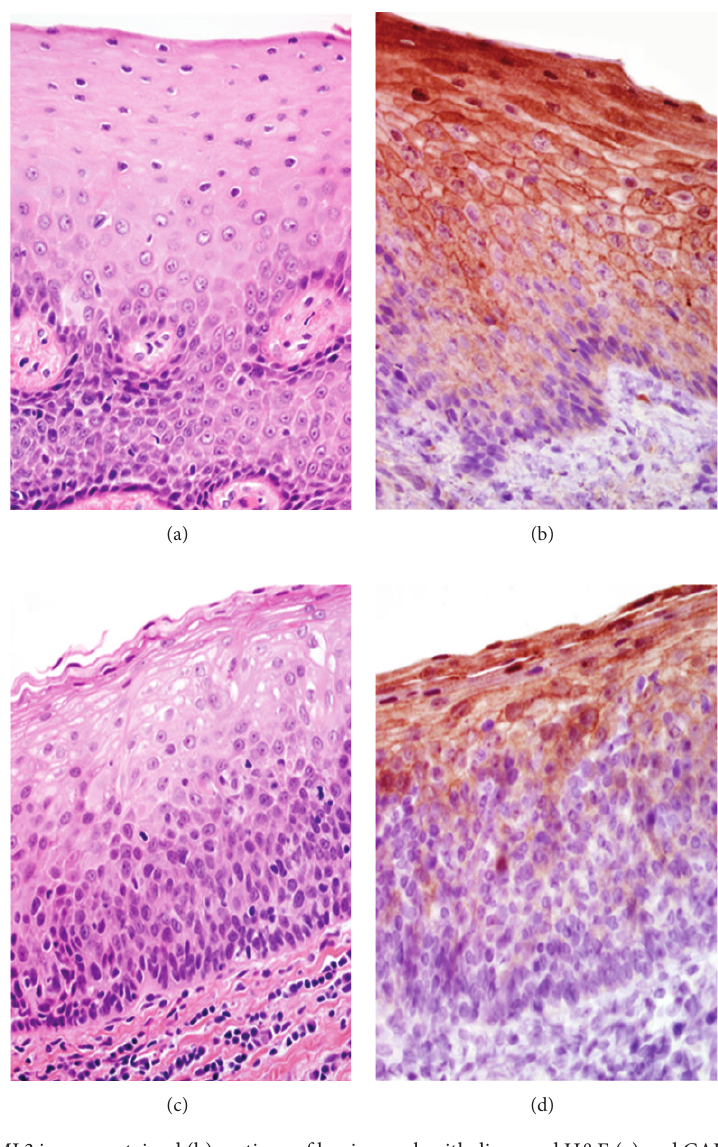
Figure 1: H&E (a) and CALML3 immunostained (b) sections of benign oral epithelium and H&E (c) and CALML3 immunostained (d) sec- tions of dysplastic oral mucosa under high power light microscopy (200x). Immunostaining is more intense towards the superficial layers with an apparent lack of CALML3 expression from the more basaloid cells. Dense cytoplasmic membrane staining and nuclear staining can be